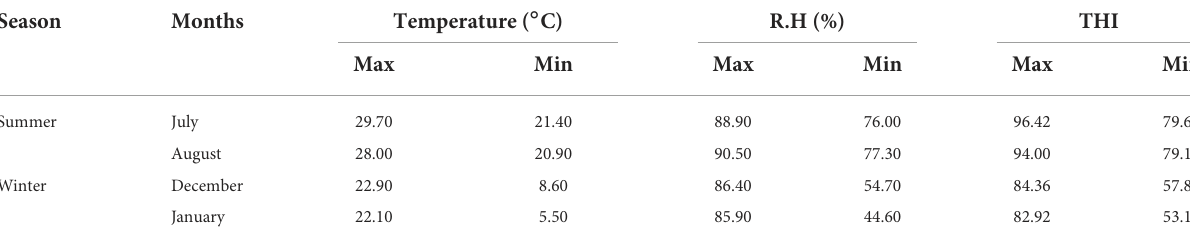
TABLE 1 Maximum and minimum temperature, relative humidity, and THI recorded during experimental period.